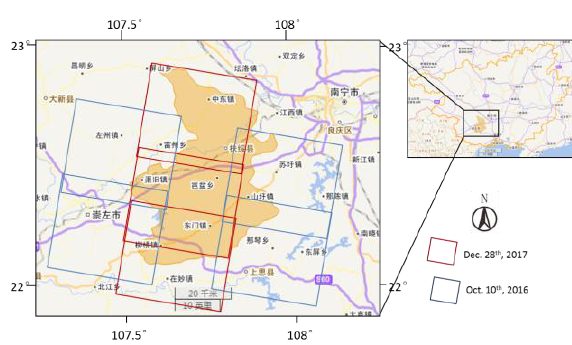
Figure 1. Experimental clip of ZY-3 images.